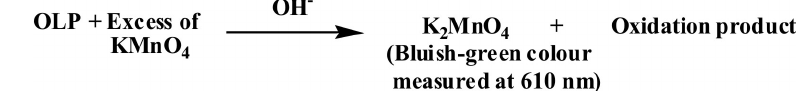
Scheme 2 - Method B. Reaction scheme.